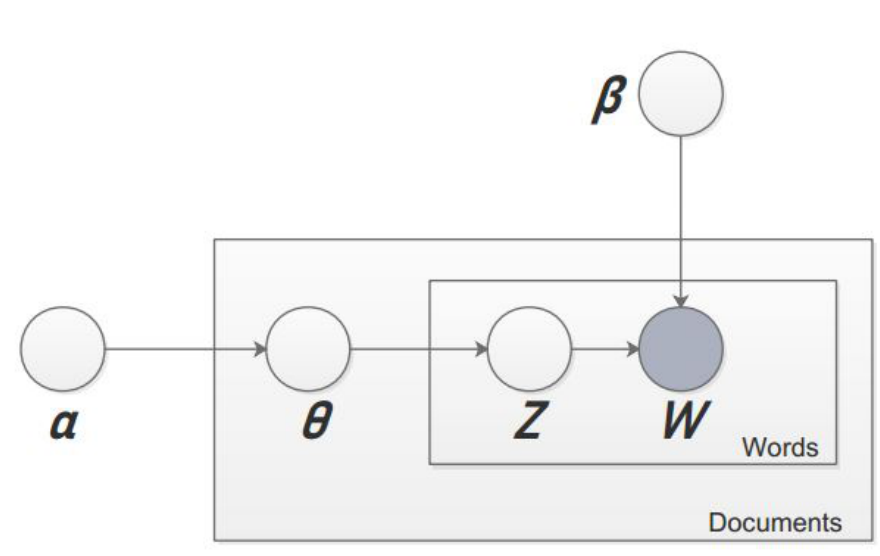
Figure 1. Generative Model LDA